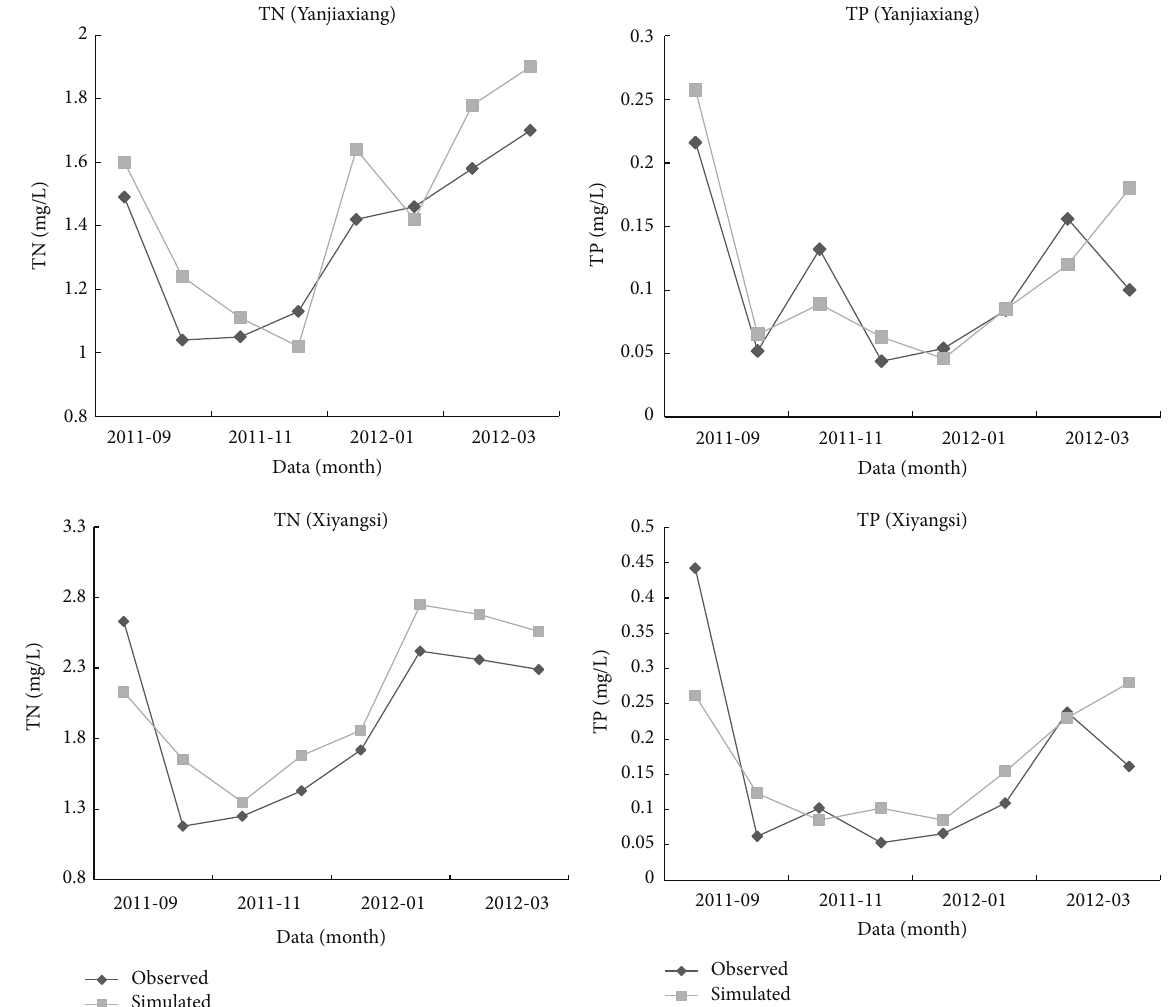
Figure 7: Observed and simulated TN and TP at Yanjiaxiang or Xiyangsi (monthly validation period).